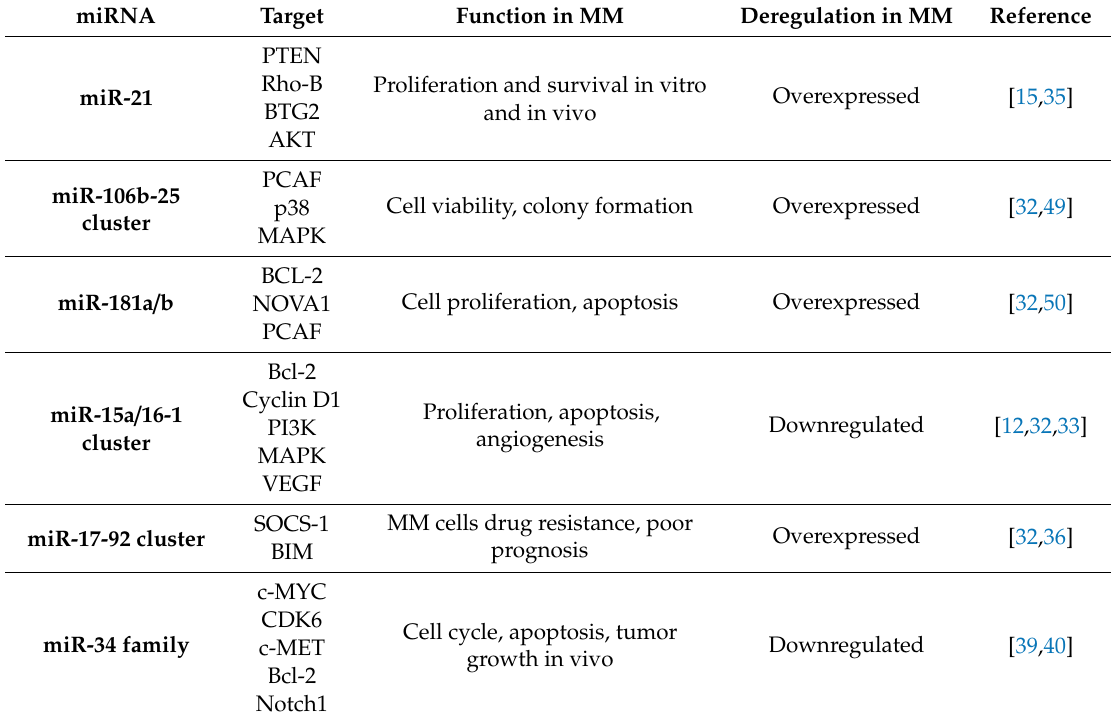
Table 1. Deregulated miRs in multiple myeloma